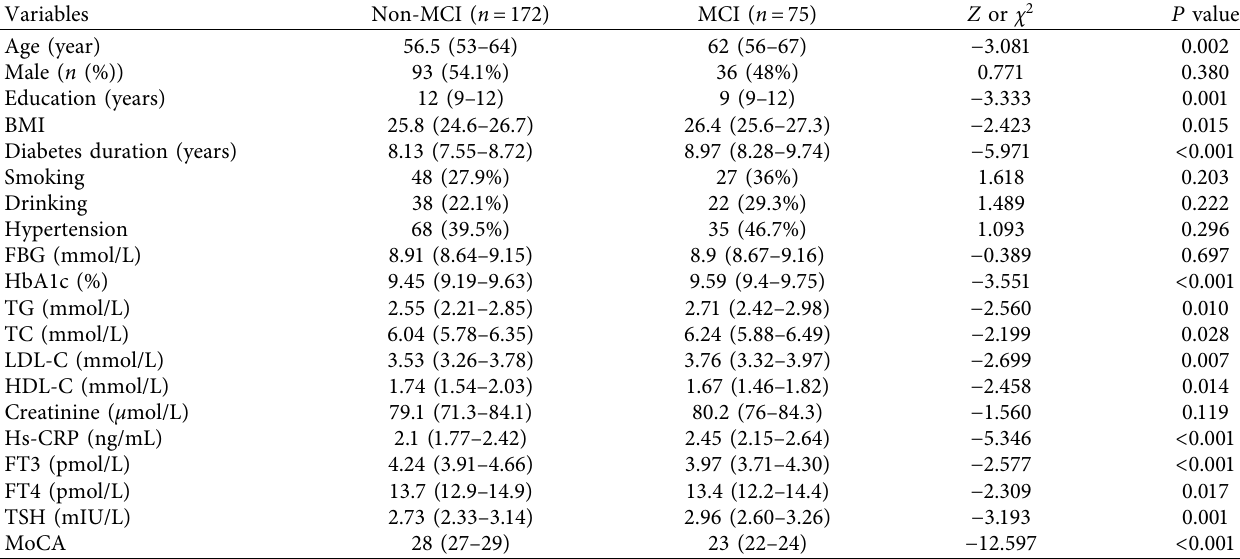
Table 1: Demographic and clinical characteristics of study population.